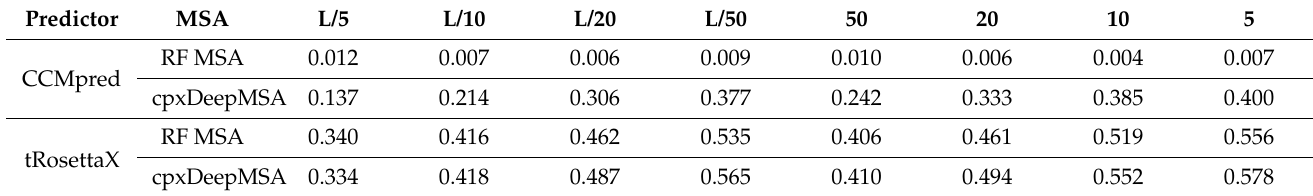
Table 2. Inter-protein contact prediction precision (%) on Baker’s